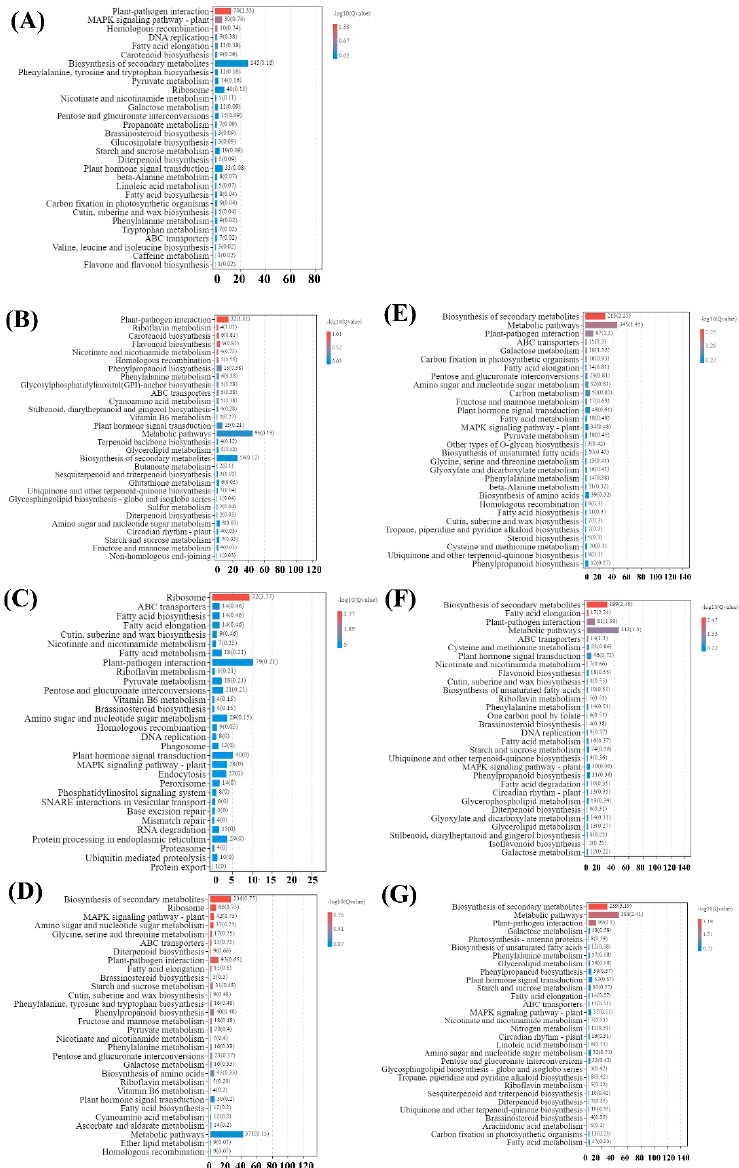
Figure 4. Top 30 KEGG pathways enrichment analysis of DEGs in PMV-infected plants leaves versus CK. ( A ) CK vs. ML, ( B ) CK vs. G1, ( C ) CK vs. G2, ( D ) CK vs. G3, ( E ) CK vs. Y1, ( F ) CK vs. Y2, ( G ) CK vs. Y3.